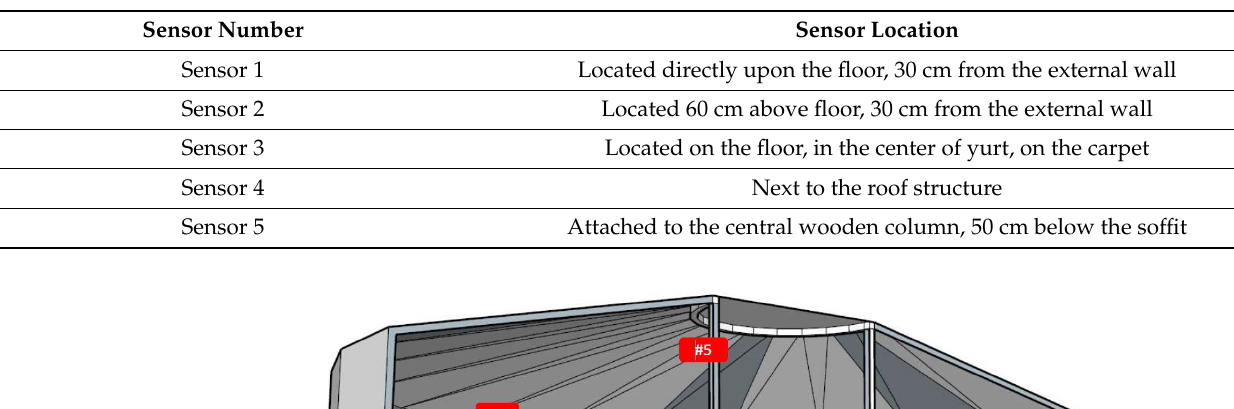
Table 2. Description of sensors’ locations.